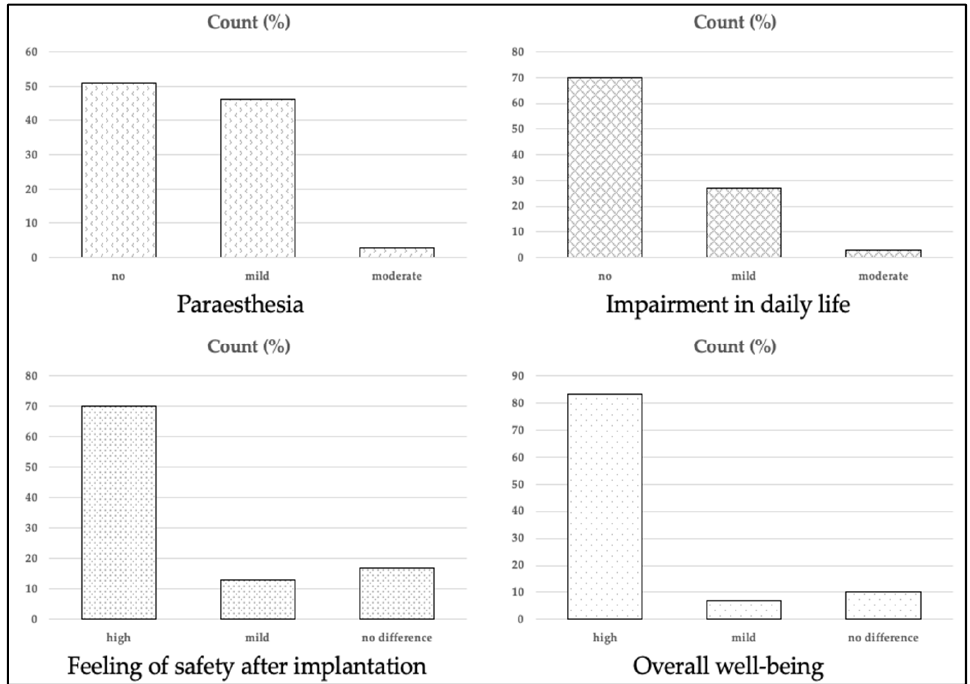
Figure 4. Evaluation of questionnaire answers provided by the study population.